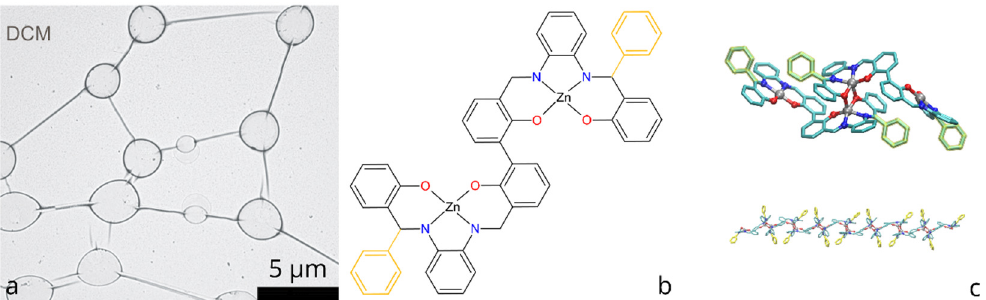
Figure 1. ( a ) Self-assembled molecular network of bis-(Zn)salphen compound, obtained by drop-casting from DCM (preprinted with a permission from Ref. [8]); ( b ) Chemical structure of bis-(Zn)salphen compound, functional phenyl rings are highlighted with yellow; ( c ) 3D rendering of a coordination bonded dimer of the compound and a fragment of a polymer chain of such dimers Ref [13].